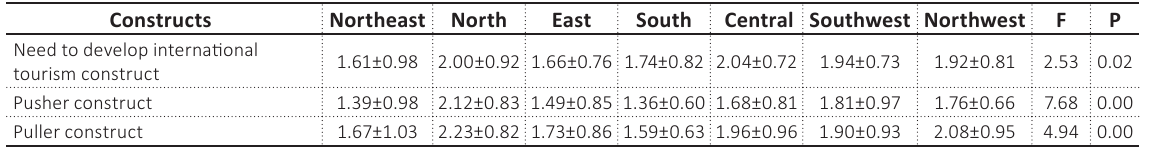
Table 9. Location difference analysis